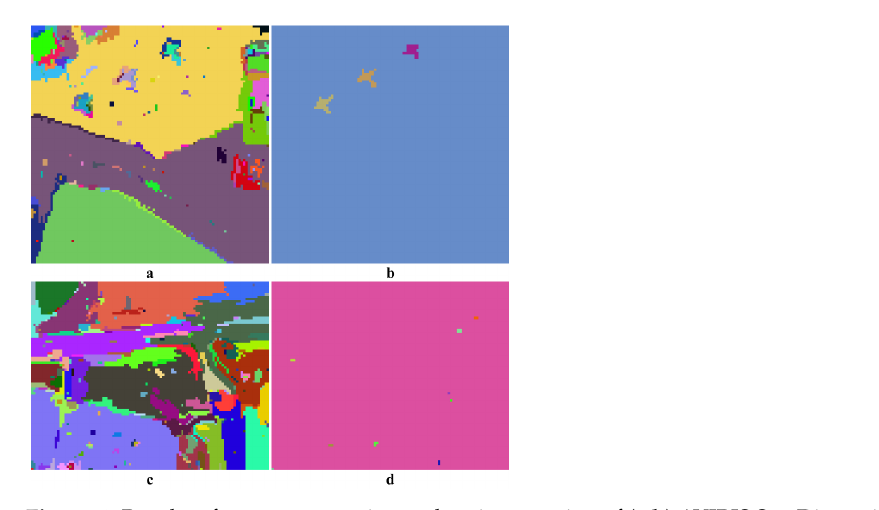
Figure 4. Results of oversegmentation and region merging of ( a , b ) AVIRIS San Diego airport dataset; ( c , d ) HYDICE urban dataset. ( a ) The result of oversegmentation for the San Diego dataset, ( b ) the result of region merging for the San Diego dataset, ( c ) the result of oversegmentation for the Urban dataset, ( d ) the result of region merging for the Urban dataset. Appl. Sci. 2021 , 11 , x